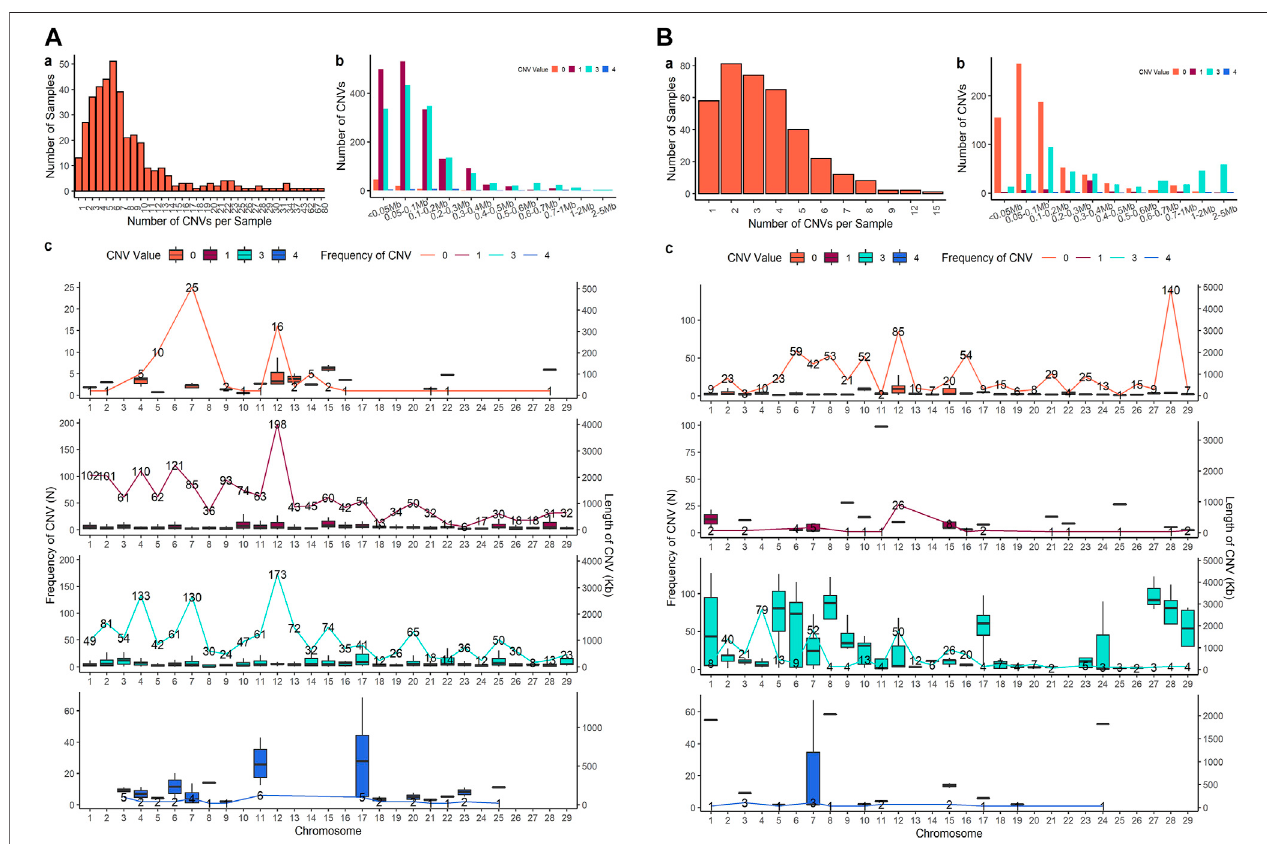
FIGURE 3 | CNVs summary plot. (A) The results of the Penn-UMD version. (B) The results of the Part-UMD version. In each panel, a shows the total number of CNVsineachindividualthatweredetected;bshowsthefrequencyofcopiesofCNVsindifferentlengthgroups;cshowsCNVsstatesanddistributiononchromosomes. The lines indicate the quantity of CNVs, bar plot presents the length